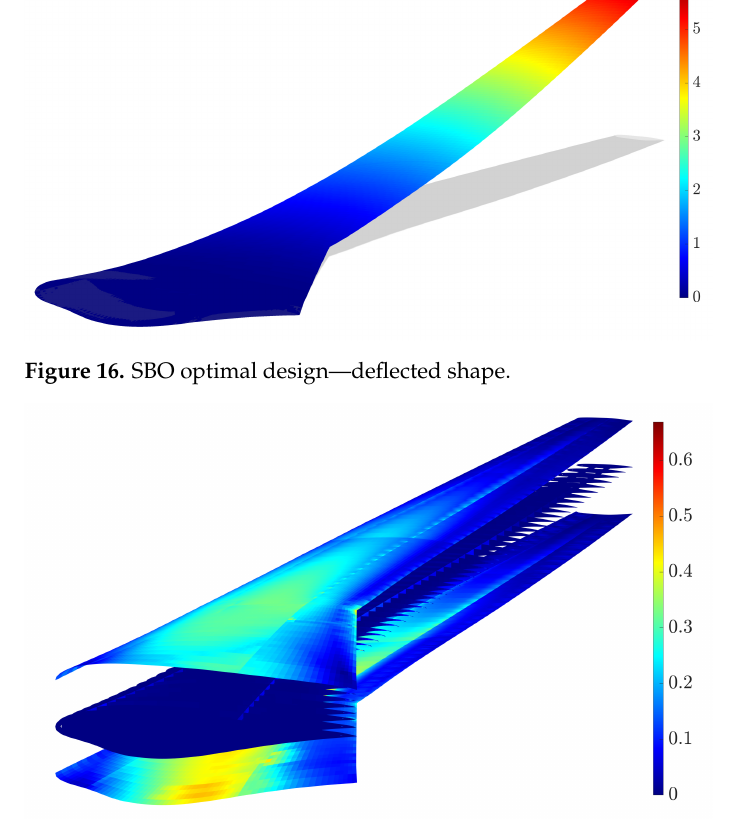
Figure 17. SBO optimal design—maximum FI at each